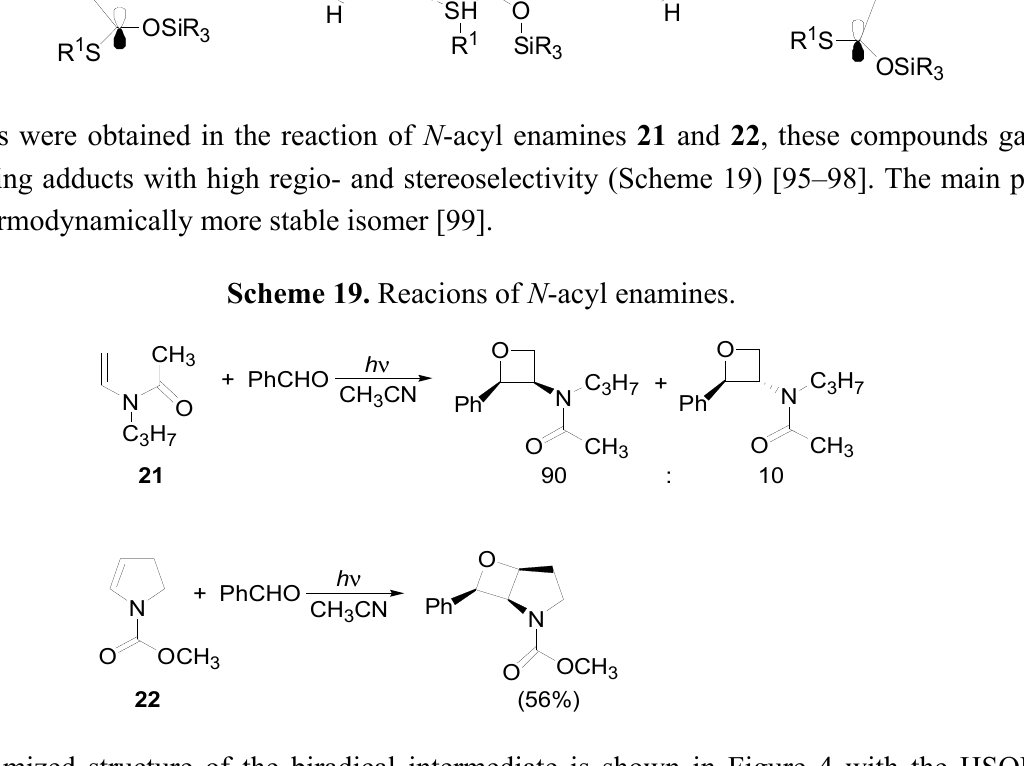
Figure 4. Optimized structure of the biradical intermediate in the reaction of compound 22